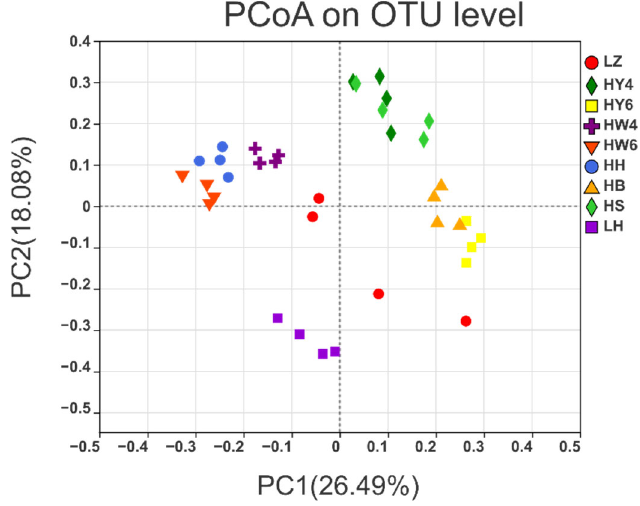
Figure 6. Principle coordinate analysis (PCoA) of the bacterial community. LZ, HY2, HY6, HW2, HW6, HH, HB, HS, and LH; continuous cropping of C. chinensis for 5 years, maize continuous cropping for 2 years, maize continuous cropping for 6 years, P. multiflorum continuous cropping for 2 years, P. multiflorum continuous cropping for 6 years, sweet potato continuous cropping for 2 years, F. thunbergia continuous cropping for 2 years, cabbage continuous cropping for 2 years, and fallow field, respectively.